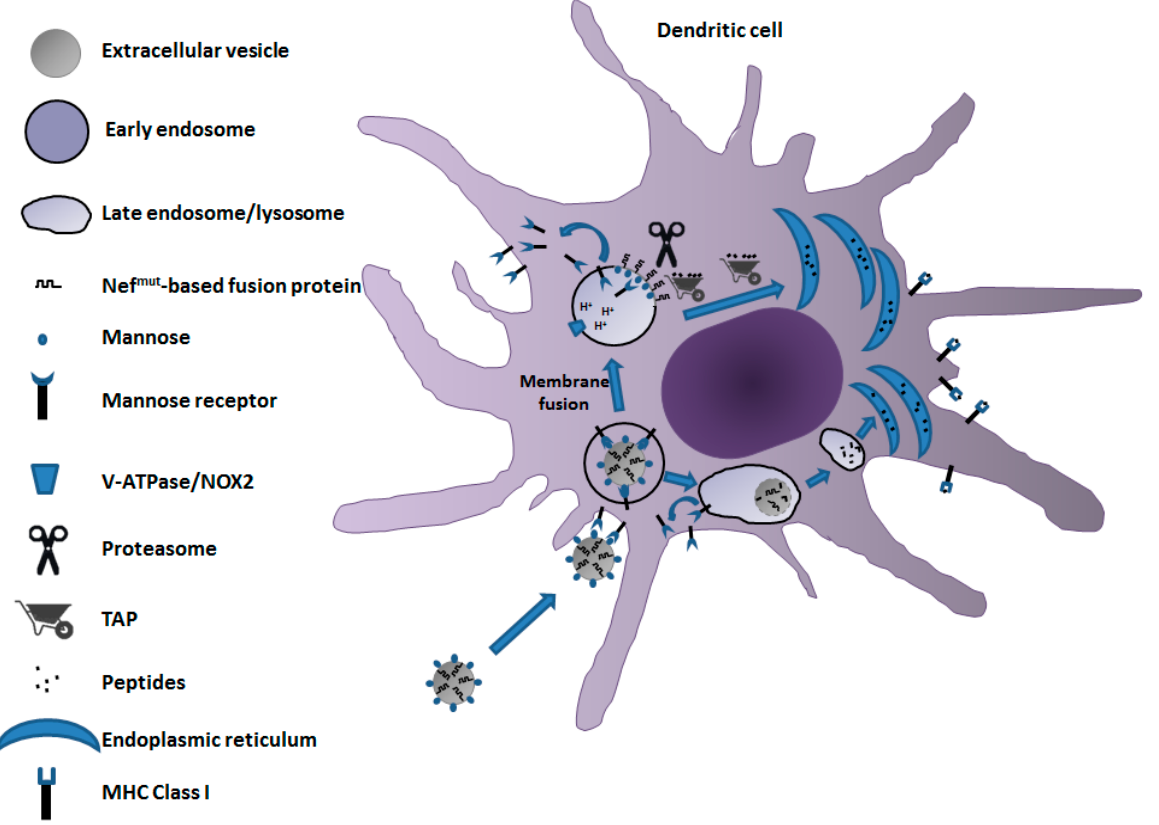
Figure 2. A model for the mechanism of cross-presentation of Nef mut -based antigens delivered by engineered EVs. EVs expressing mannose on their membrane and incorporating high levels of Nef mut -based fusion products bind to MR expressed by DCs. EV–DC interaction results in EV cell internalization by endocytosis. The endosome acidification leads to conformation change of the mannose receptor and its recycling toward the cell membrane. Cross-presentation of peptides from Nef mut -based fusion products can result from the vacuolar (bottom flow) and/or cytoplasmic (upper flow) pathways. In the latter case, endosome and EV membranes undergo fusion, ultimately leading to a single-membrane endosomal body with membrane-associated Nef mut -based fusion products exposed to cytoplasm. In this way, Nef mut -based fusion proteins become available for proteasome-mediated degradation. The resulting peptides are transported by TAP into ER, where they associate with the MHC class I complex to initiate the cross-priming process.